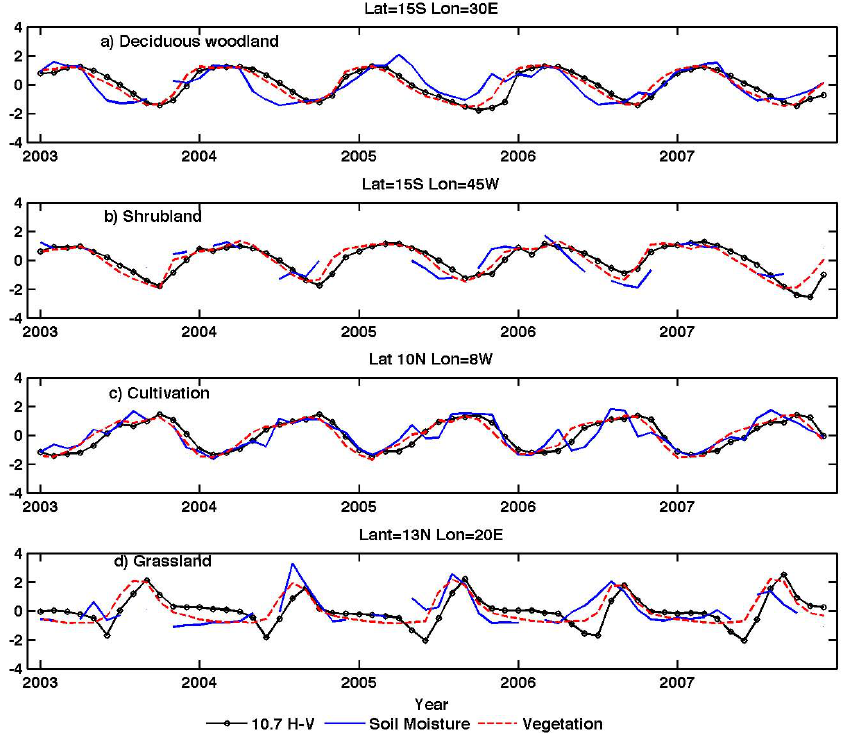
Fig. 7. (a–d) Normalized monthly mean variation of emissivity polarization difference at 10.7GHz (H-V), NDVI, and soil moisture content at different locations from January 2003 to December 2007. The vegetation types of these locations are (a) deciduous woodland (b) shrubland (c) cultivation (d)